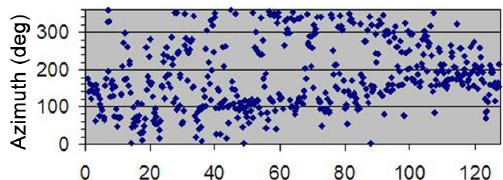
Figure 8. Azimuthal distribution of ambient noise sources during time periods from 1 January to 30 April 2012 and from 10 to 31 December 2012 estimated by beam forming in the time domain. Numbers on the abscissa axis correspond to the relative day num- bers (see the text for additional